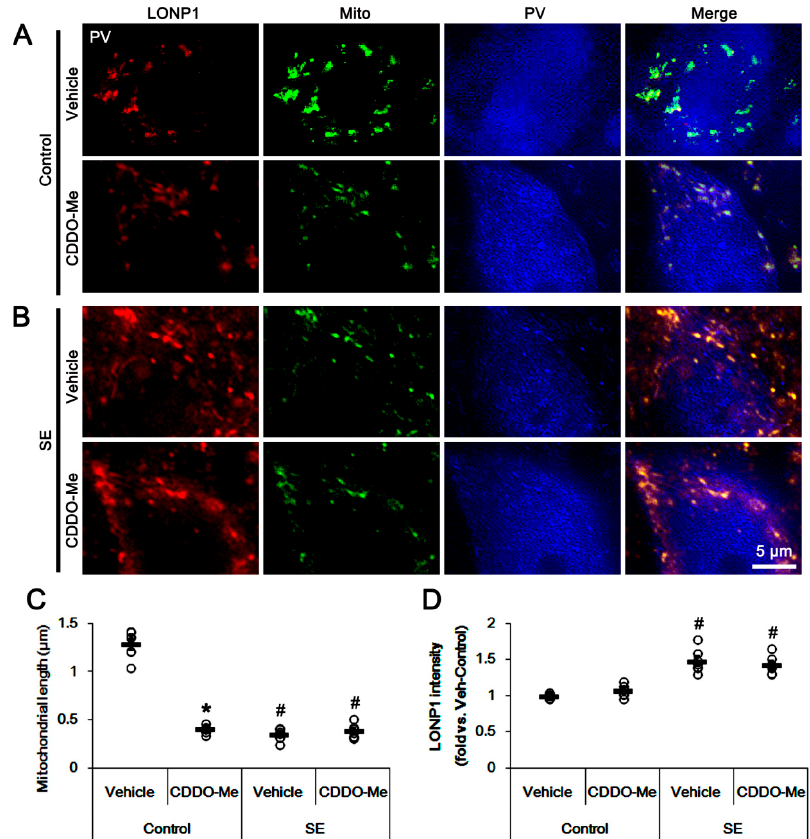
Figure 3. Effects of CDDO-Me on mitochondrial length and LONP1 expression in parvalbumin (PV) cells. CDDO-Me reduces mitochondrial length in CA1 neurons of ( A ) control- and ( B ) post-SE animals. CDDO-Me does not affect the increased LONP1 expression following SE. ( A , B ) Representative photos of LONP1, mitochondria (Mito) and PV. ( C , D ) Quantifications of ( C ) the mitochondrial length and ( D ) LONP1 fluorescent intensity in PV cells. Open circles indicate each individual value. Horizontal bars indicate mean value. Error bars indicate SEM (* ,# p < 0.05 vs. vehicle and control animals, respectively; n = 7, respectively).